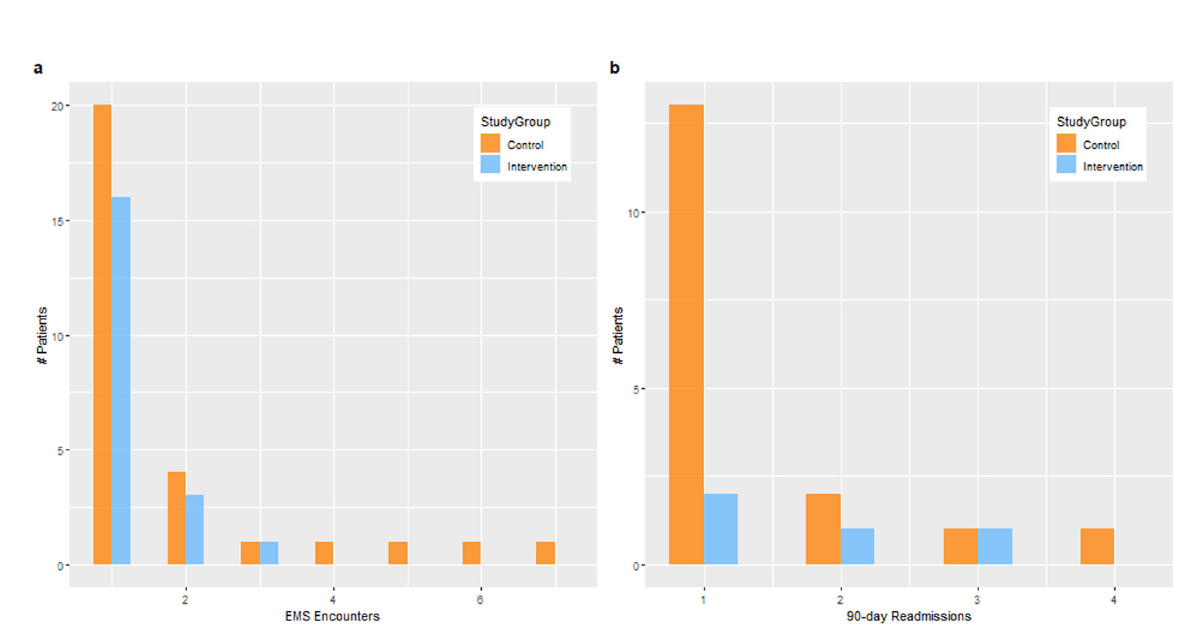
Fig. 2 Patients with single vs. multiple (a) EMS encounters and (b) 90-day readmissions. Figure 2 summarizes between-groups differences in patients with 1 event versus those with multiple events for EMS encounter and 90-day readmission